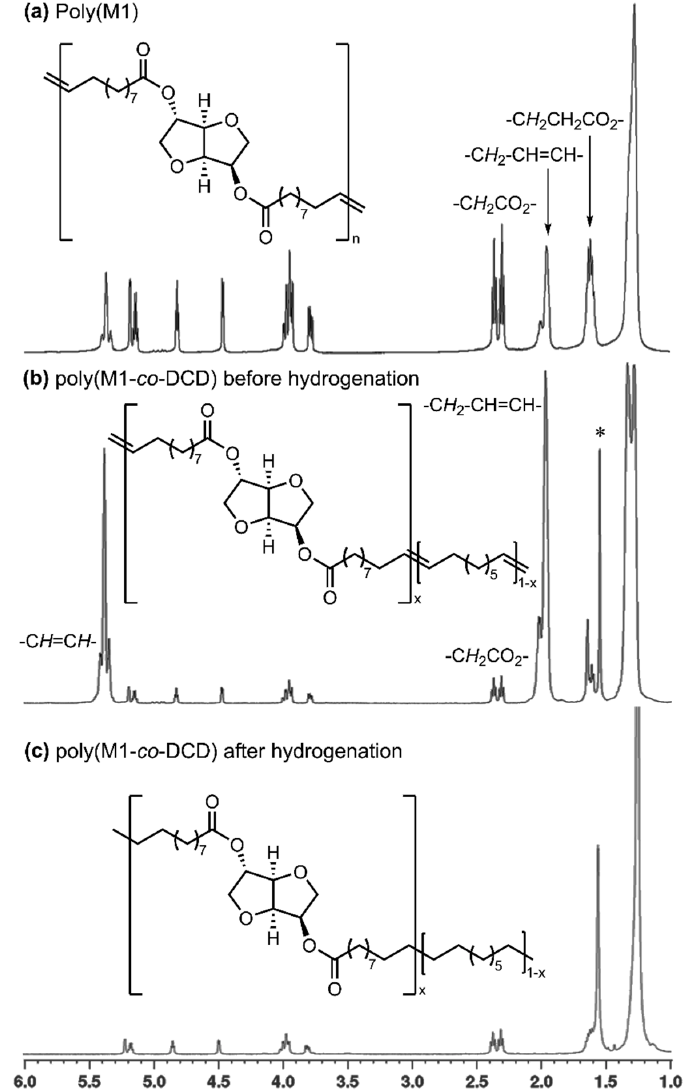
Figure 2. 1 H spectra (in CDCl 3 at 25 °C) for ( a ) poly(M1), ( b ) poly(M1 ‐ co ‐ DCD) (before hydrogenation, run 6), and ( c ) hydrogenated poly(M1 ‐ co ‐ DCD) (run 6). Resonance marked with * is water (impurity).